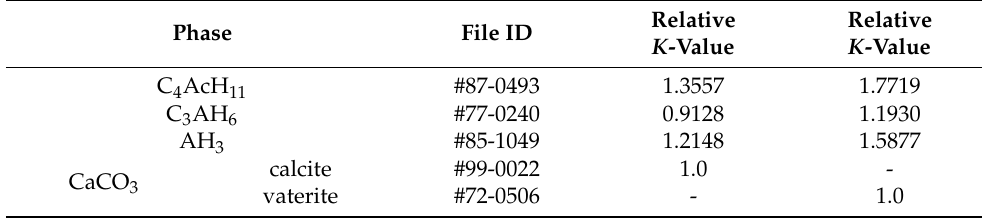
Table 1. Relative K value of